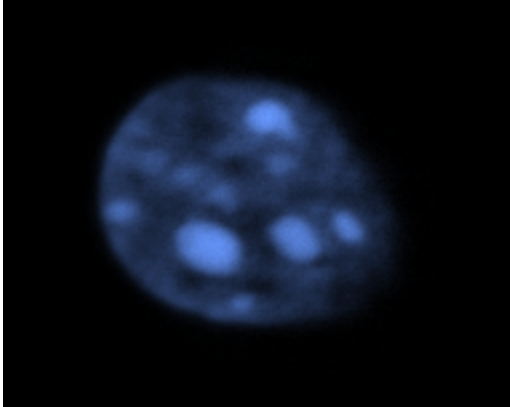
Figure 1. DNA visualization in fixed murine 3T3 cell nucleus using minor groove binder 4',6-diamino-2-phenylindole (DAPI). The image was kindly provided by Dr. C. Escudé (CNRS, UMR 7196, Paris,